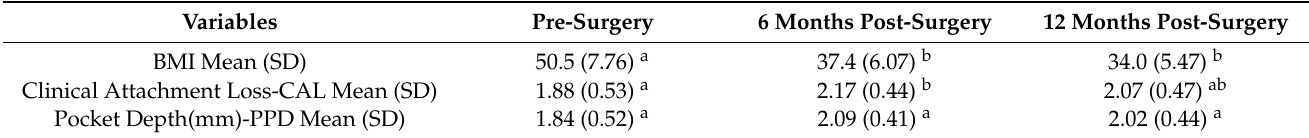
Table 1. Mean and standard deviation of the clinical assessments and pocket depth of bariatric patients before and after Roux-en-Y gastric bypass surgery.